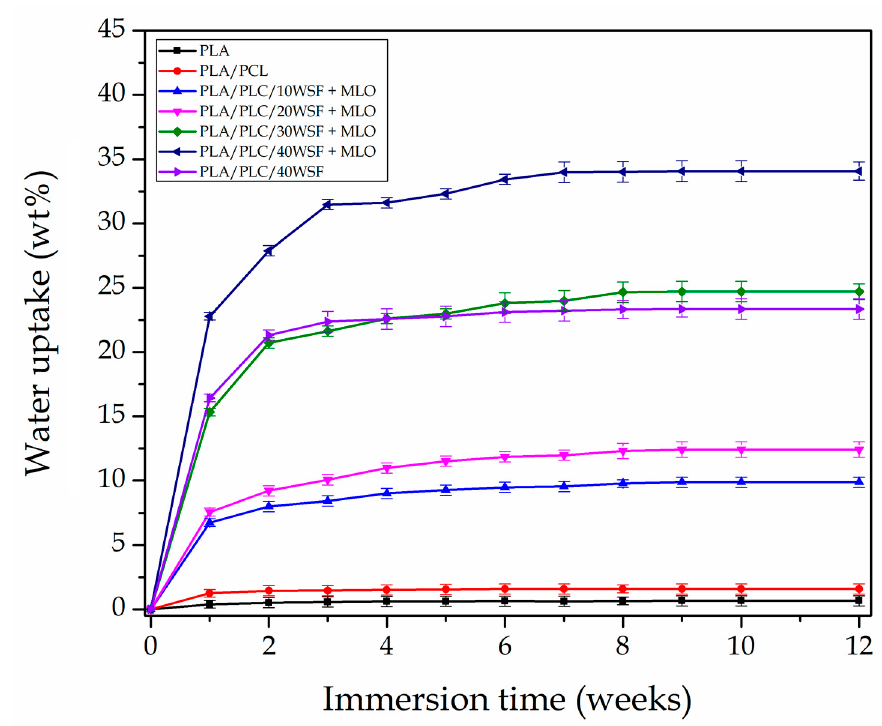
Figure 7. Water uptake of the green composites made of polylactide (PLA), poly( ε -caprolactone) (PCL), walnut shell flour (WSF), and maleinized linseed oil (MLO).